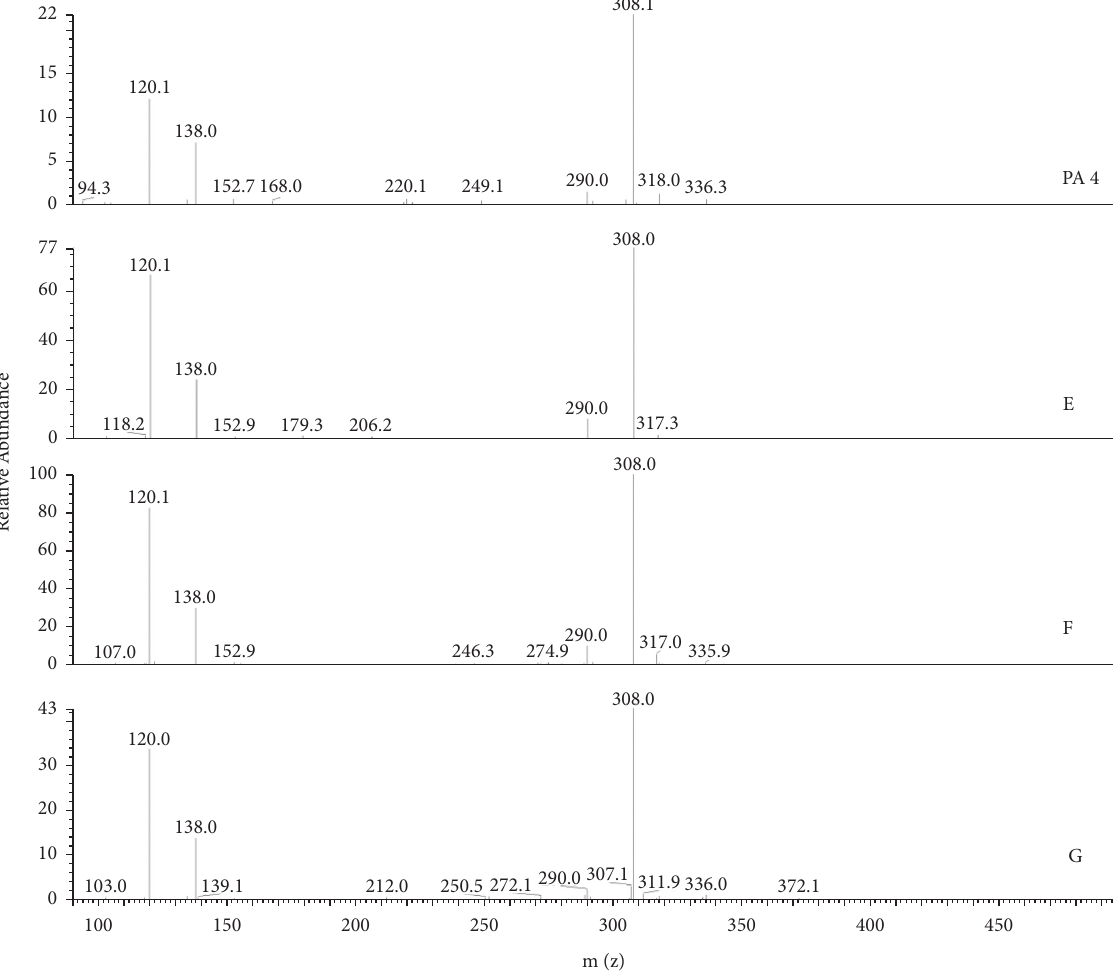
Figure 6: MS/MS spectrum of PA4 and peaks E, F, and